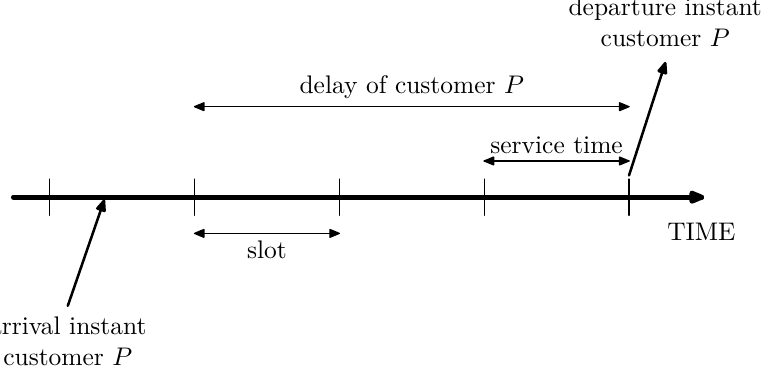
Figure 1. The delay of customer P